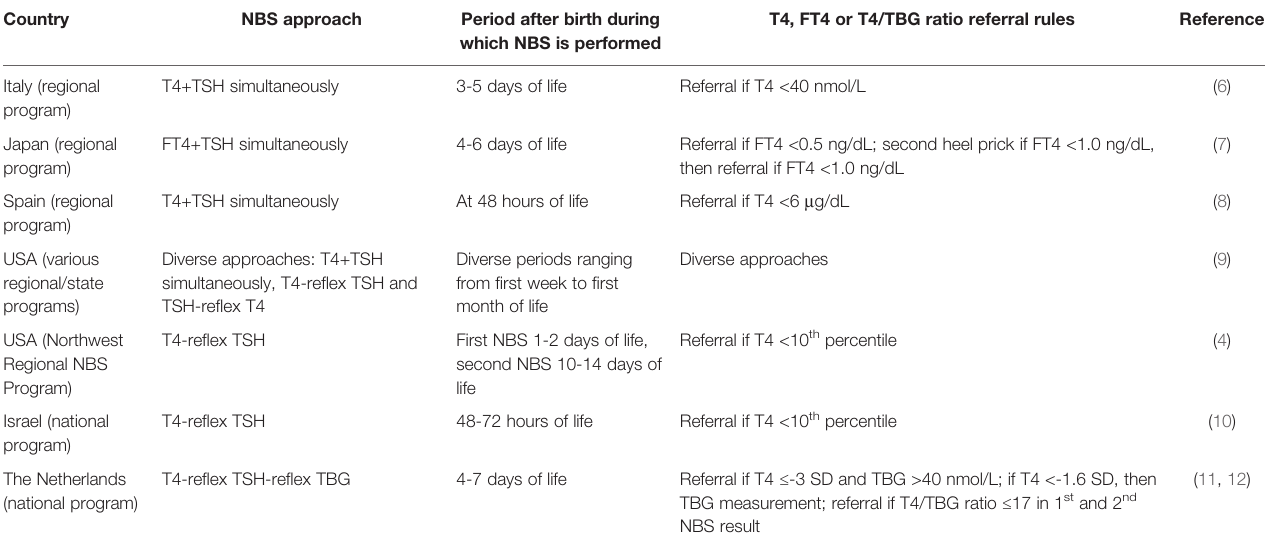
TABLE 1 | Characteristics of NBS programs screening for both primary and central CH.